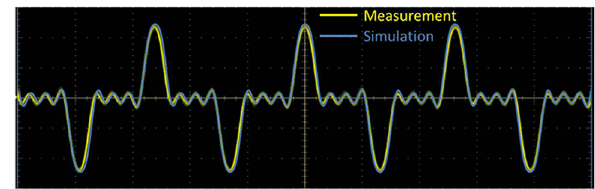
FIG. 23. Comparison of the combined kick pulse from the oscilloscope display image capture with the